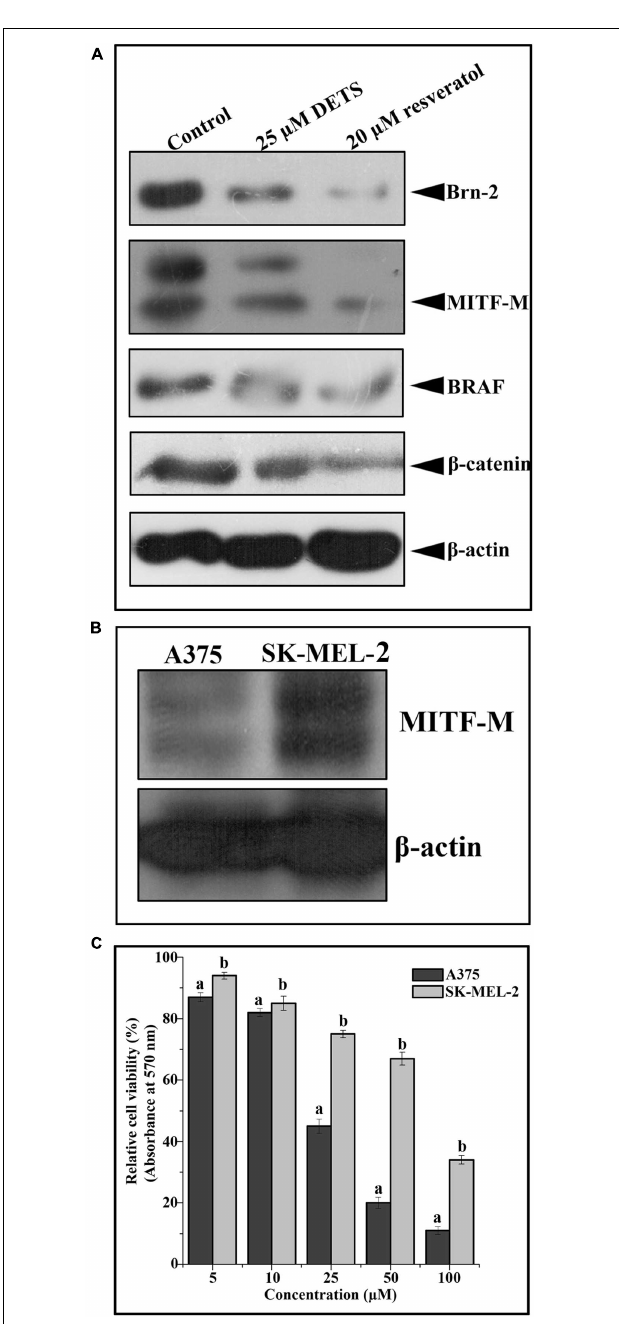
FIGURE 7 | DETS down-regulates survival signals prevalent in melanoma. (A) DETS down-regulates activation of survival signals such as BRAF, Brn-2, β -catenin and MITF-M. Whole-cell extracts were prepared after treating A375 cells with indicated concentration of DETS as well as resveratrol for 24 h and subjected to Western blotting using antibodies against BRAF, Brn-2, β -catenin and MITF-M. (B) The expression status of MITF-M in A375 and SK-MEL-2. Whole-cell extracts were prepared with A375 and SK-MEL-2 cells and subjected to Western blotting using antibodies against MITF-M and β -actin. (C) Comparison of two melanoma cells A375 with SK-MEL-2. Cells were seeded in 96 well plate, treated with DETS for 48 h and subjected to MTT assay. All results shown here are representative of three independent experiments with similar